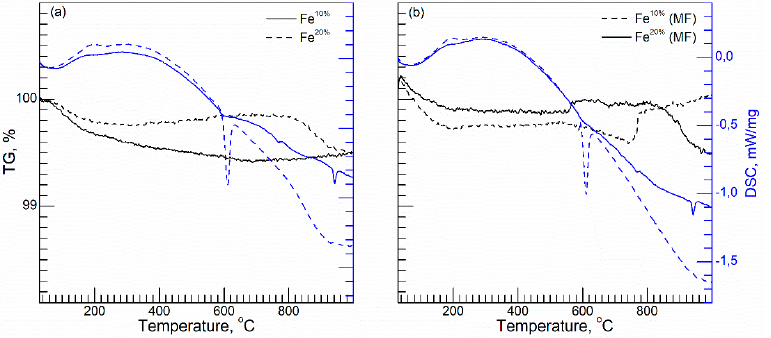
Figure A1. TG and DSC graphs of Fe 10% and Fe 20% powders in Ar ( a ) without magnetic field (MF) and ( b ) with external MF.